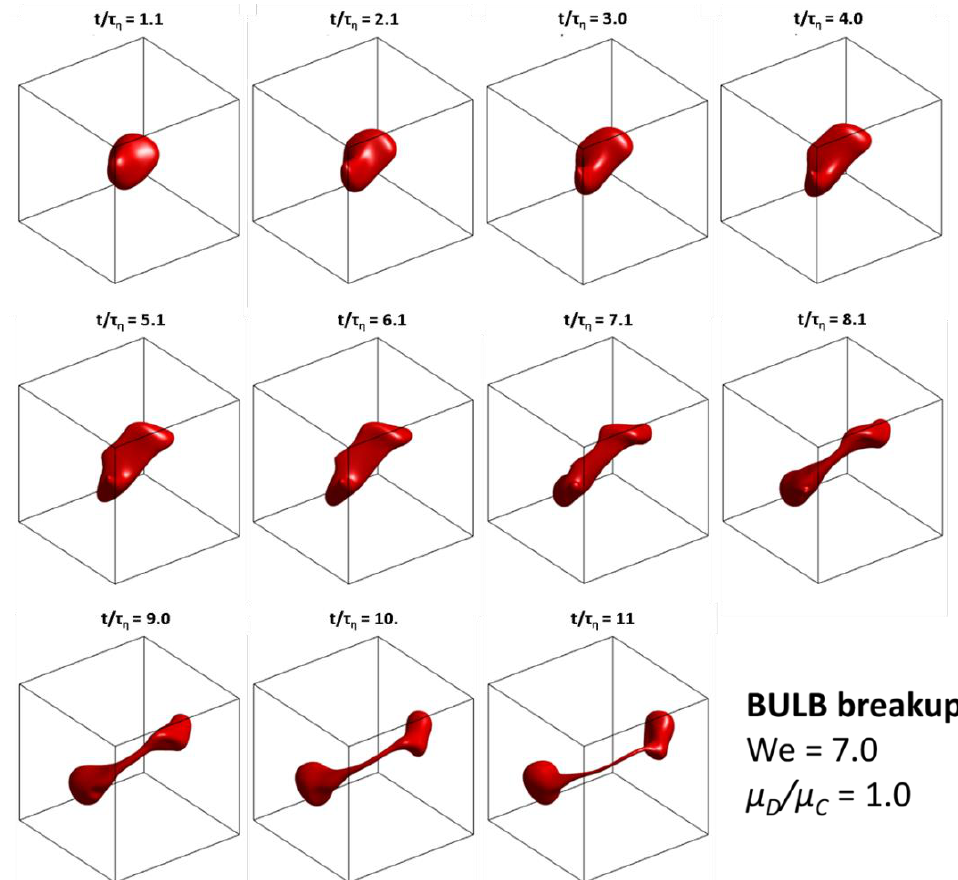
Figure 4. Breakup sequence for We = 7.0, µ D / µ C = 1, illustrating the bulb breakup morphology. (Iso-surfaces at α = 0.5).